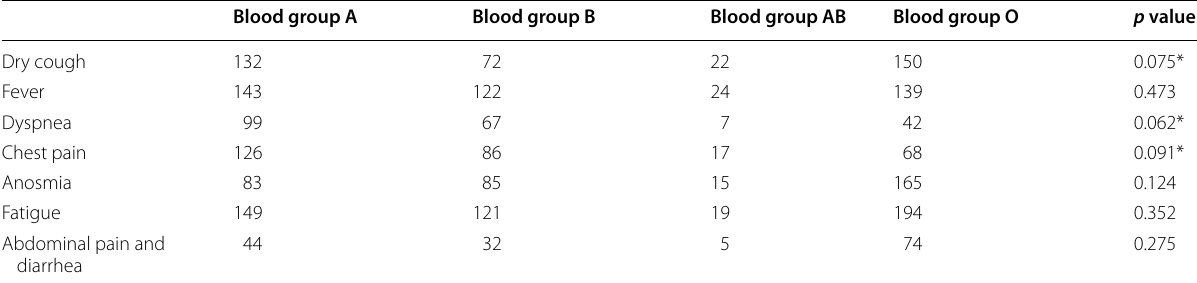
Table 2 The common presenting symptoms, number of cases in each blood group, and significance of severity